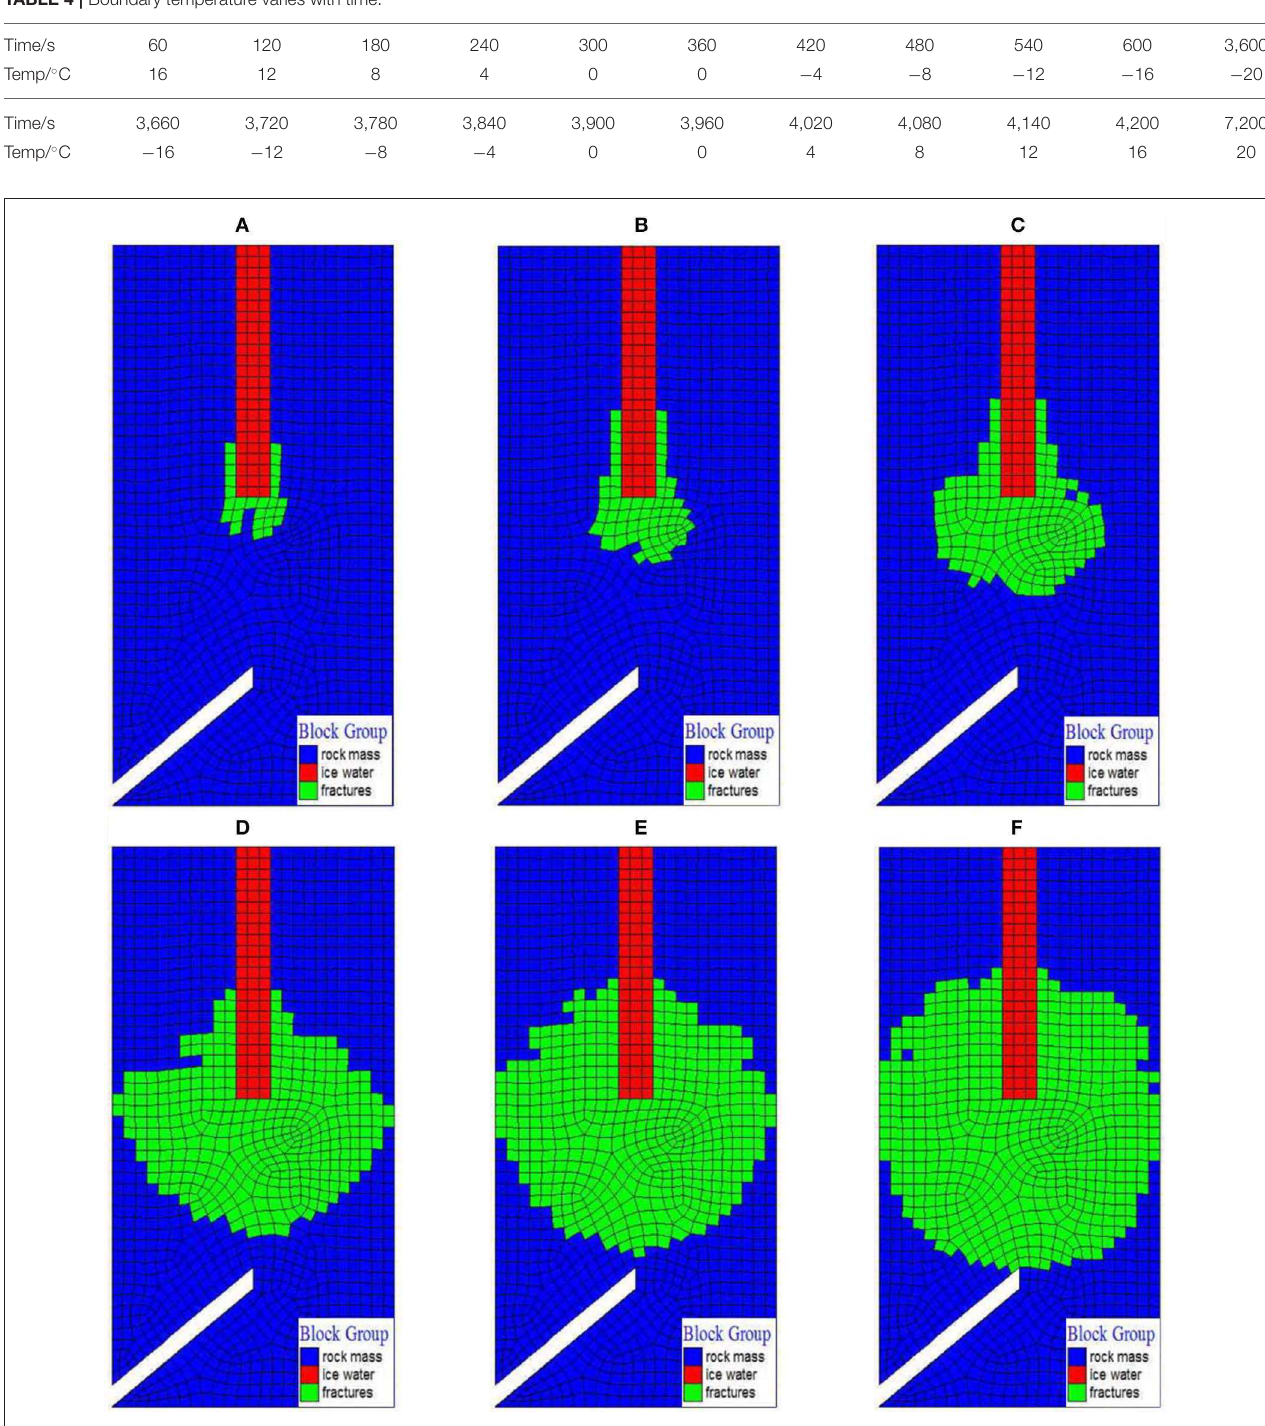
TABLE 4 | Boundary temperature varies with time.